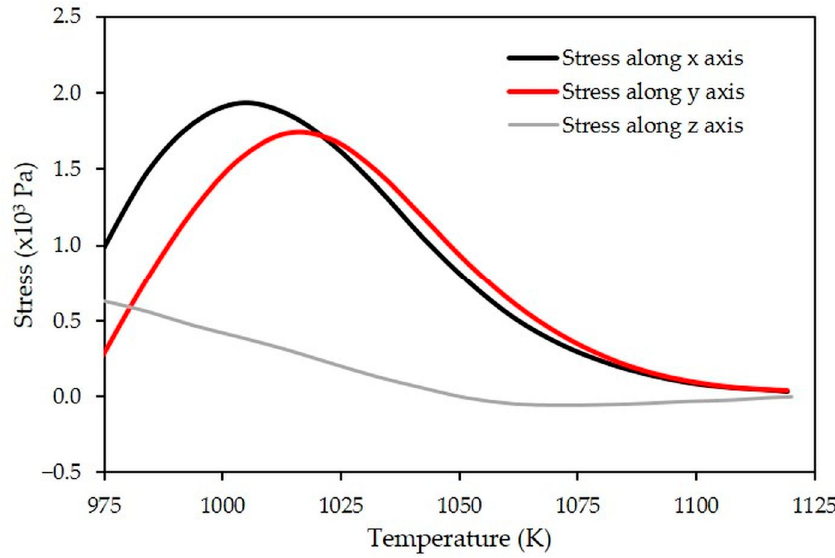
Figure 7. Simulated evolutions of the average stresses induced within the porous LTCC during constrained sintering.